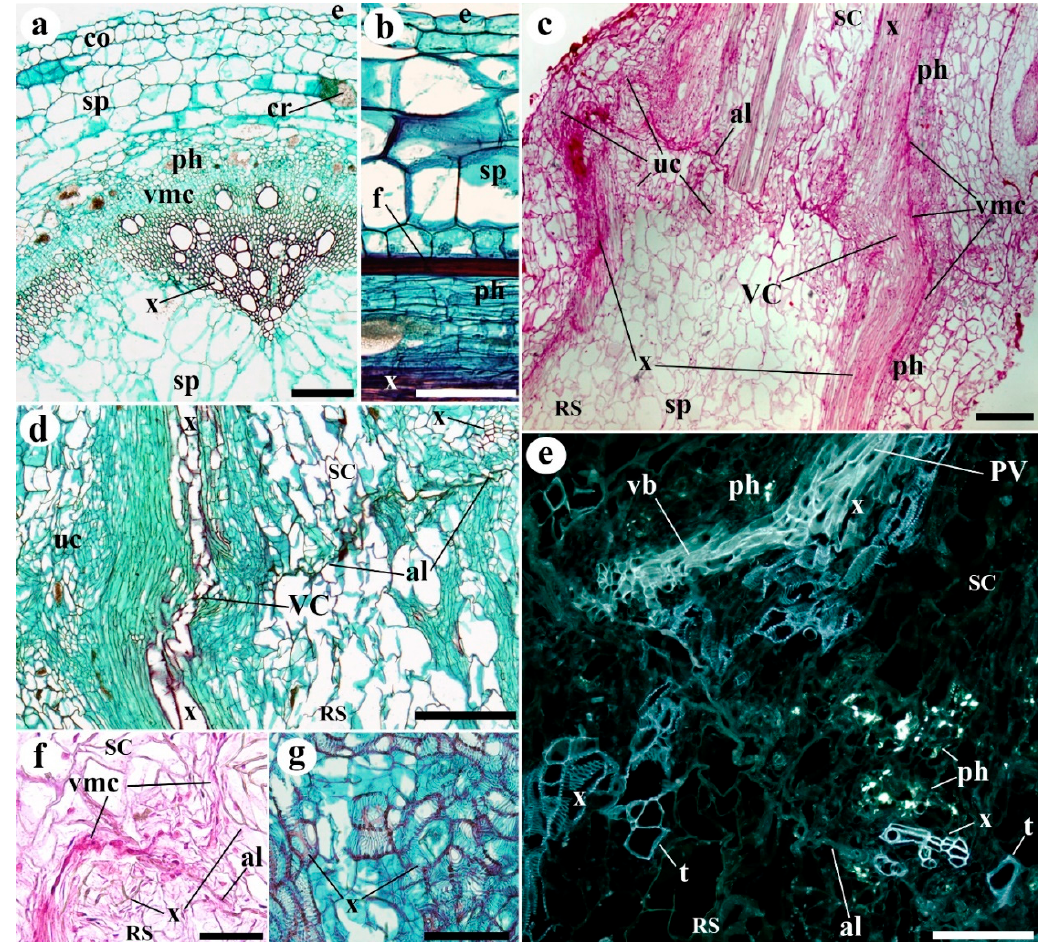
Figure 1. Representative images of stem sections of ( a , b ) 0 (non ‐ grafted) and ( c – g ) 10 days after grafting (10 DAG) plants. ( a )Transverse section of a stem of Solanum lycopersicum (Minibel) showing the distribution of the tissues during primary growth. ( b ) Longitudinal section of a stem; note the distribution of tissues from the exterior to interior (up ‐ down). ( c ) Longitudinal section of the graft junction area; note the adhesion line (al), the new vascular connections (VC), and the areas with undifferentiated cells (uc). ( d ) Longitudinal section of the graft junction area; note the vascular connections (VC) and adhesion line (al). Close to the adhesion line, in the scion, note the groups of xylem cells (x). ( e ) Longitudinal section of the graft junction area; note the transdifferentiated parenchyma cells (t) in the scion and rootstock, the phloem (ph, yellow points), the vascular branch (vb) arising from the pre ‐ existing vasculature (PV), and the large number of neo ‐ differentiated cells in both scion and rootstock. ( f ) Longitudinal section of the graft junction area; note the vascular connection between the scion and rootstock, and how the vascular meristematic cells make contact across the adhesion line (al). ( g ) Differentiation of conducting xylem cells within callus tissue. ( a , b , d , g ) Safranin ‐ fast green; ( c , f ) Haematoxylin ‐ Eosin; ( e ) Sirofluor. ( a – d , f , g ) Bright field view. ( e ) Epifluorescence microscopy. al adhesion line, cr microcrystals, co collenchyma, e epidermis, f fiber, PV pre ‐ existing vascular tissue, ph phloem, RS rootstock, SC scion, sp storage parenchyma, t transdifferentiating cells, uc undifferentiated cells, vb vascular branch, VC vascular connection, vmc vascular meristematic cells, x xylem. Scale bars: a, d, e = 150 μ m; b = 100 μ m; c = 300 μ m; f = 200 μ m; g = 75 μ m.